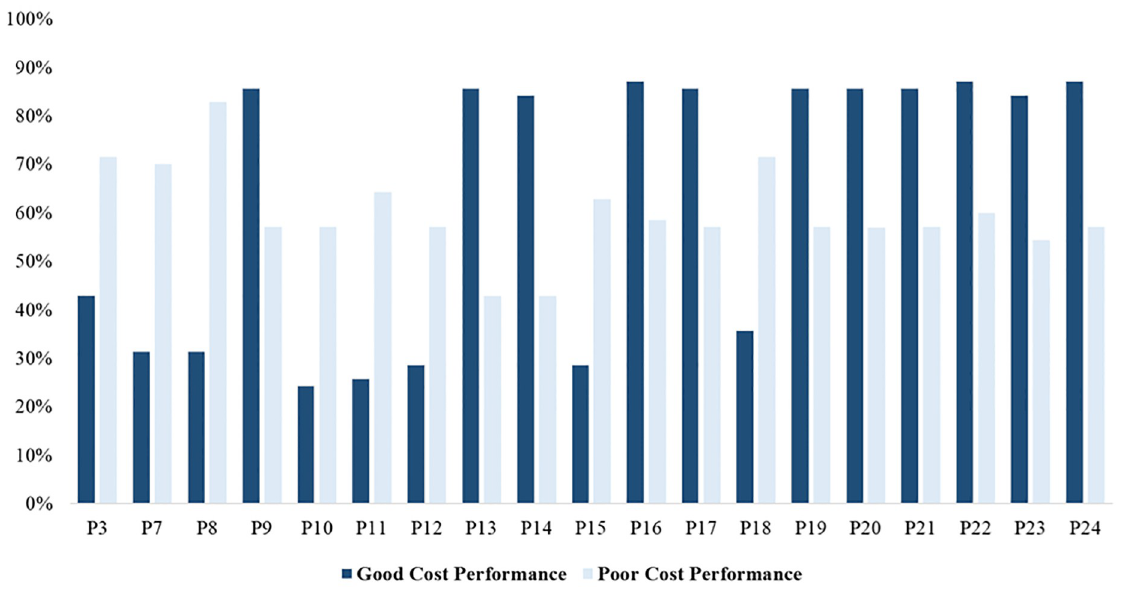
Fig 4. Comparison of scores of reconstruction cost performance predictors- Likert-scale